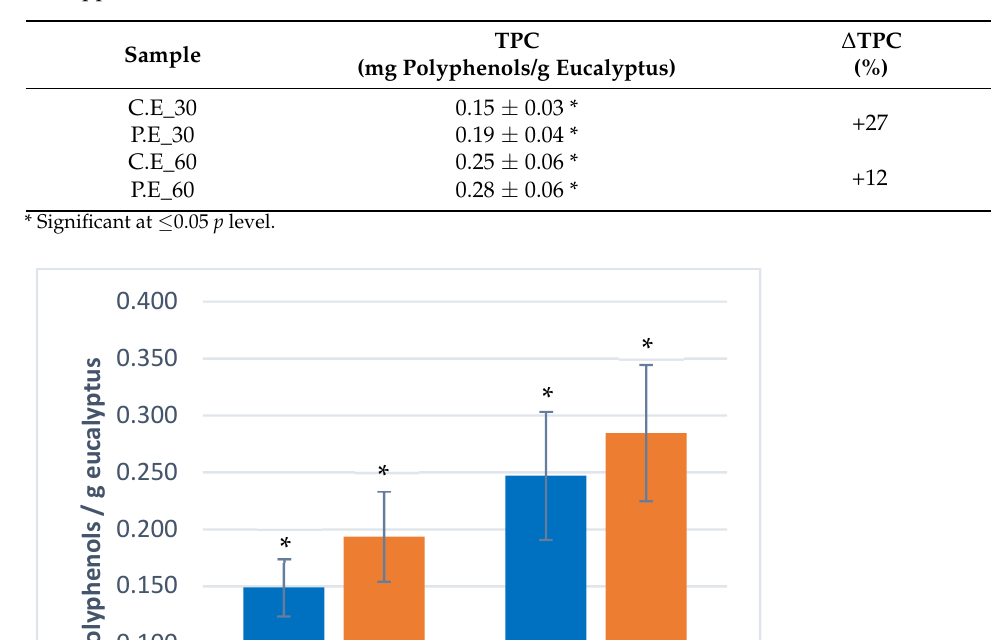
Table 5. Summarized results for TPC analysis of eucalyptus EO extracted with and without PEF application.